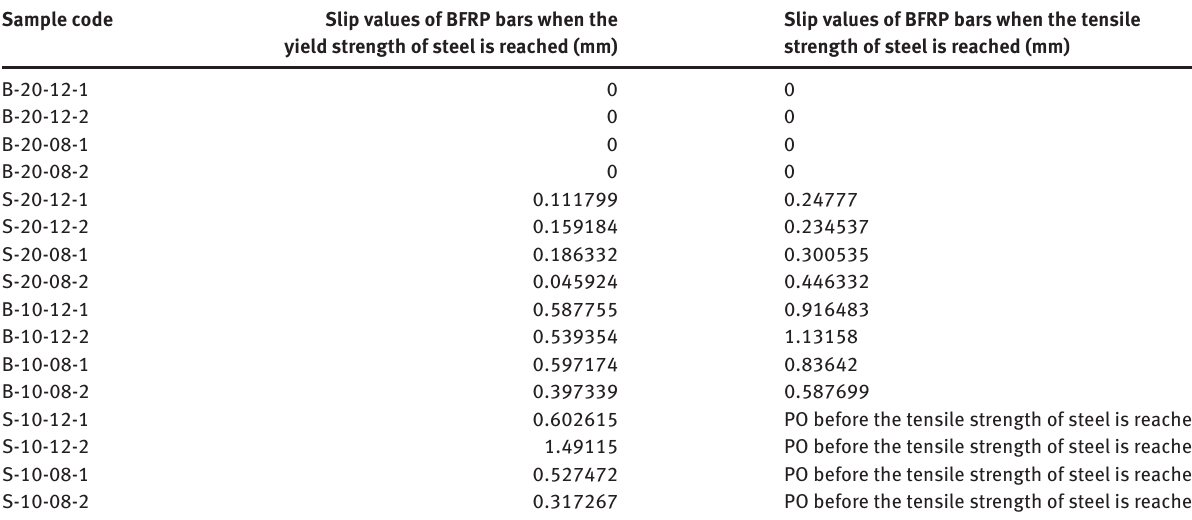
Table 6: Slip values of BFRP bars at loads required to reach the yield and tensile strength of SR. Sample code Slip values of BFRP bars when the yield strength of steel is reached